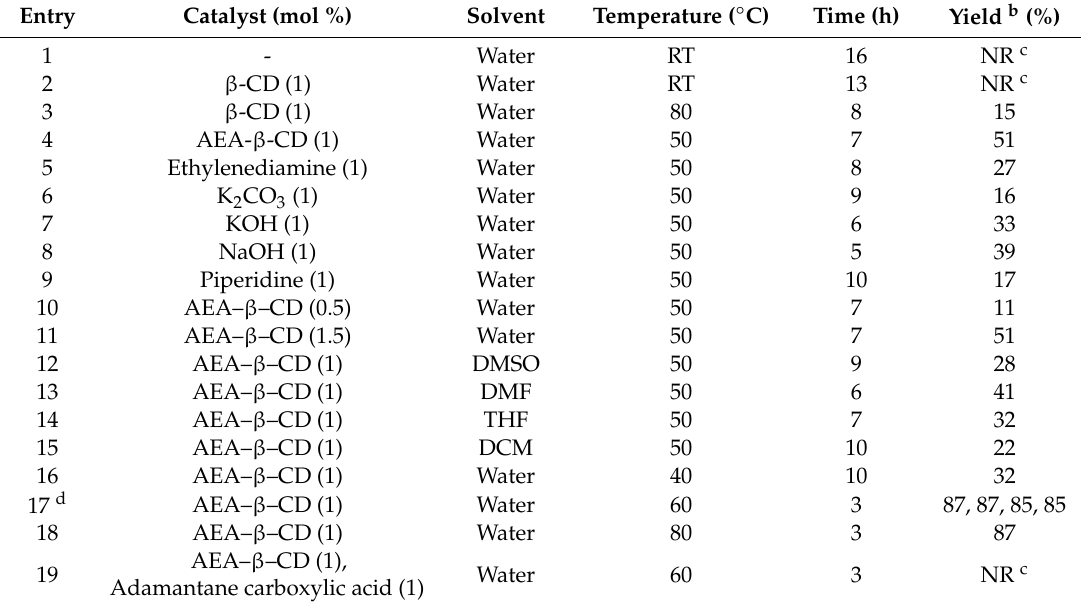
Table 2. Calculated data of phase solubility for binding constant (K c